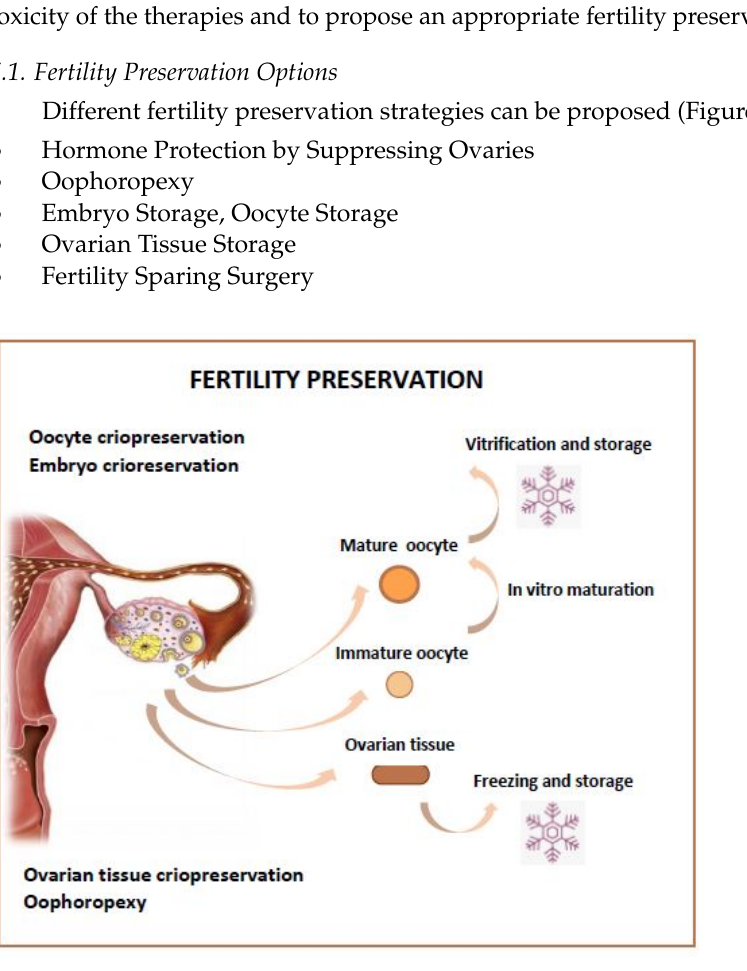
Figure 1. Fertility Preservation Options.